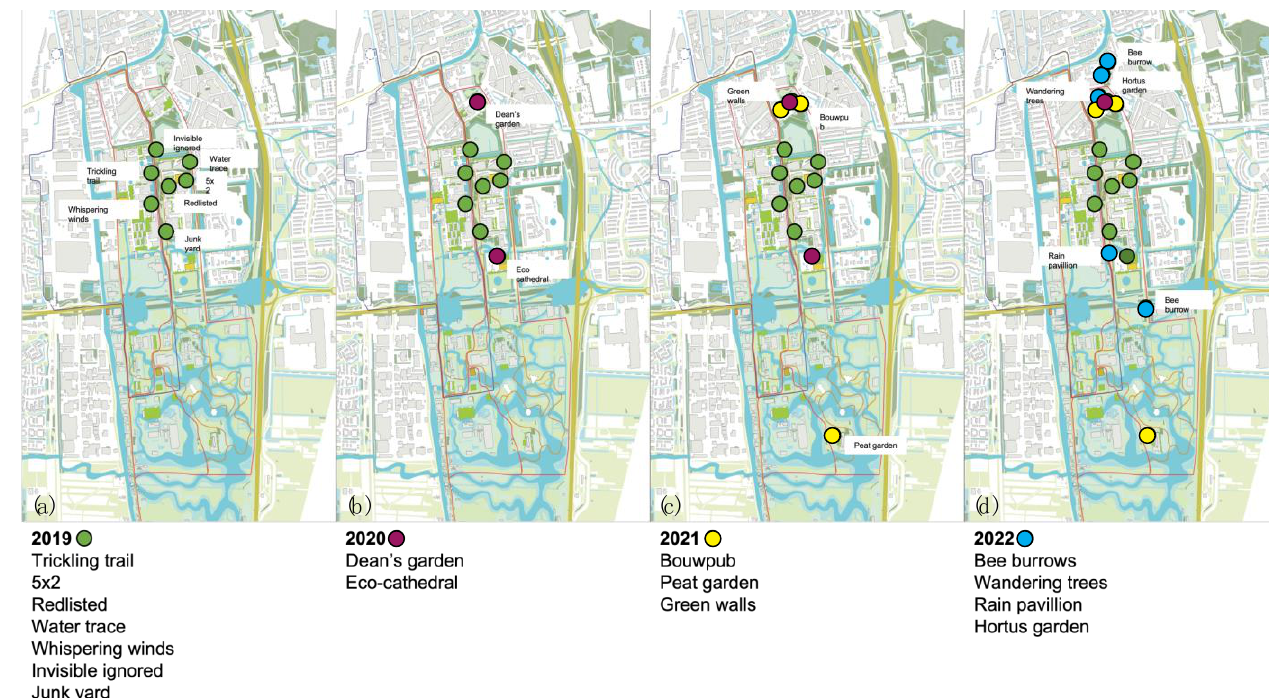
Figure 4. Transformative ecology, from individual eco-interventions to an embedded ecological framework: ( a ) projects realized in 2019, ( b ) projects realized in 2020, ( c ) projects realized in 2021 and ( d ) projects realized in 2022.